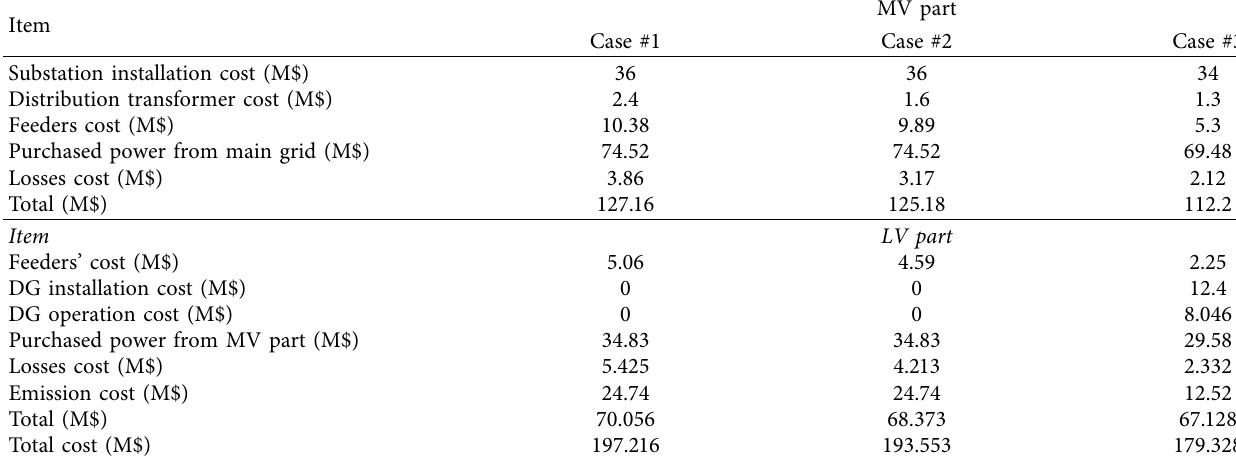
lines are illustrated by dotted and solid lines, respectively, in Figure 6. The candidate nodes for installing distribution transformers are shown by the letter “ T ” beside them. All the low-voltage nodes are candidates for installing DGs. Twelve